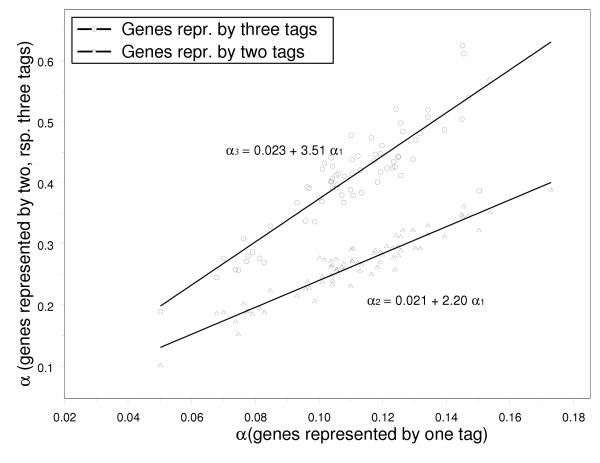
Estimates of α in the untruncated model. For each library, the estimates for genes mapped to two tags, and the estimates for genes mapped to three tags, are plotted against the estimate for genesmapped to a single tag.